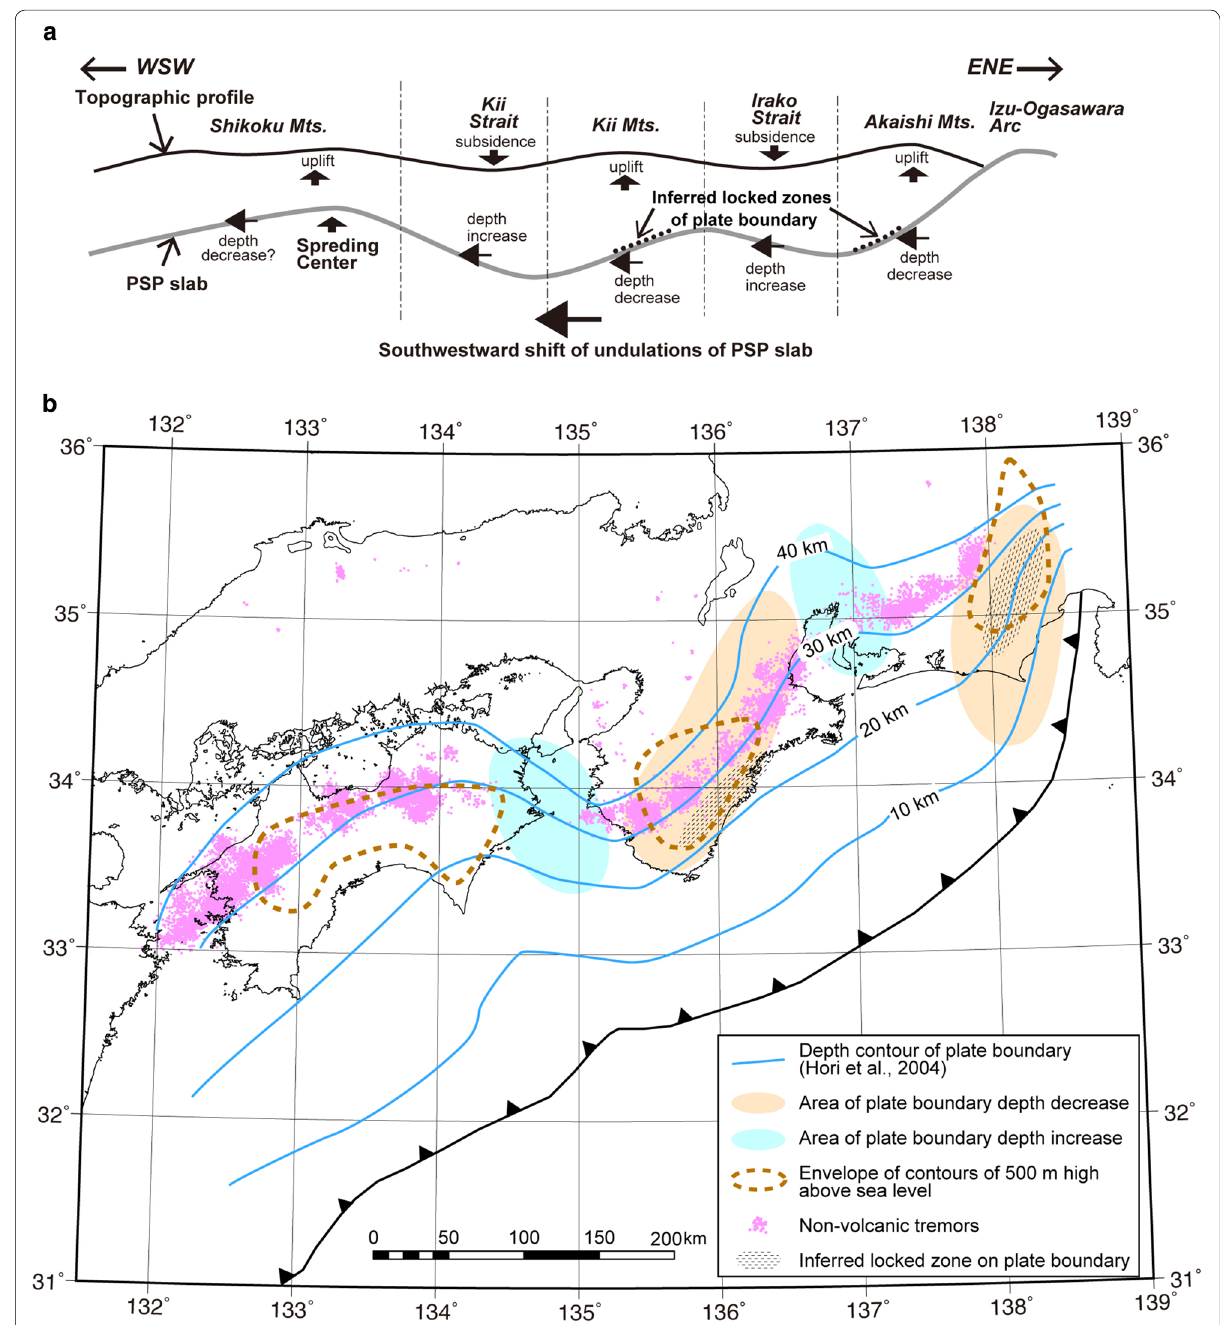
Fig. 6 Relationship between the vertical movement of the forearc wedge and the plate boundary. a Schematic cross section showing the geometry of the plate boundary and the uplift and subsidence zones along the Outer zone of southwest Japan. Top solid line indicates a topographic profile of the forearc wedge and the bottom solid line show geometry of the plate boundary. Ridges and troughs of the plate boundary are supposed to move to the southwest as shown by horizontal arrows due to oblique subduction of the PSP slab, then the depth of the plate boundary changes. The areas of increase and decrease of the plate boundary depth approximately correspond to the subsidence and uplift zones of the forearc wedge, respectively. b Map showing the relationship between the depth contours of the plate boundary and crustal movement of the forearc, and the location of inferred stack zone on the plate boundary. Areas of plate boundary depth decrease are inferred to correspond to the areas where the plate depth contours strike NE–SW, and the those of plate boundary depth increase are inferred to correspond the areas of depth contours strike E–W to NW–SE. The mountains in the Outer zone (dashed outlines) approximately coincide with the area of plate boundary depth decrease. Plate boundary is inferred to be locked where the depth of the plate boundary decreases. The uplift zone of the Shikoku Mountains is not clearly explained by this model. The non-volcanic tremor locations are from the JMA catalog from 2014 to